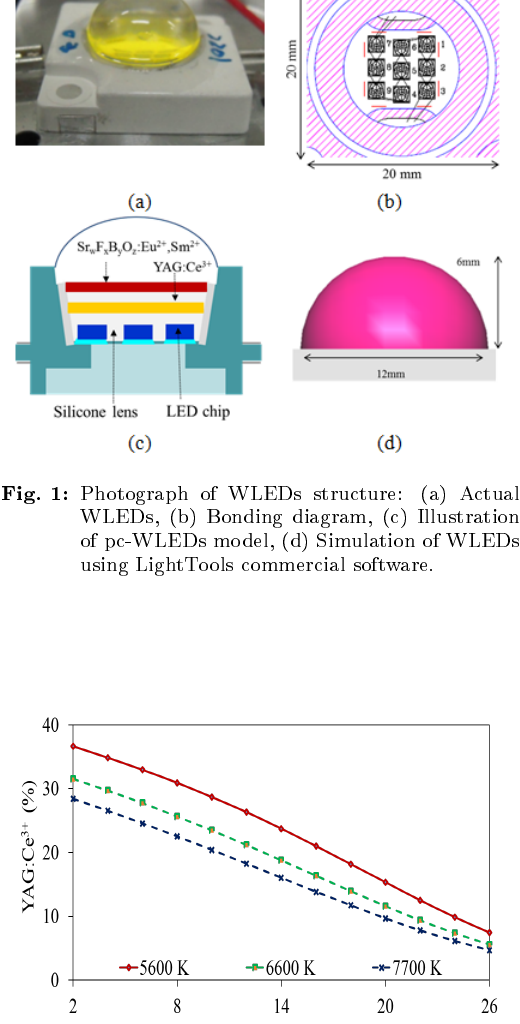
nance of average CCTs and the other is the in(cid:29)u- ence of change on scattering and absorption in WLEDs. This inevitably a(cid:27)ects the color qual- ity and luminescence generated by WLEDs. The purpose of red phosphor grade is to increase the color quality. However, the reduction of lumi- nous (cid:29)ux can